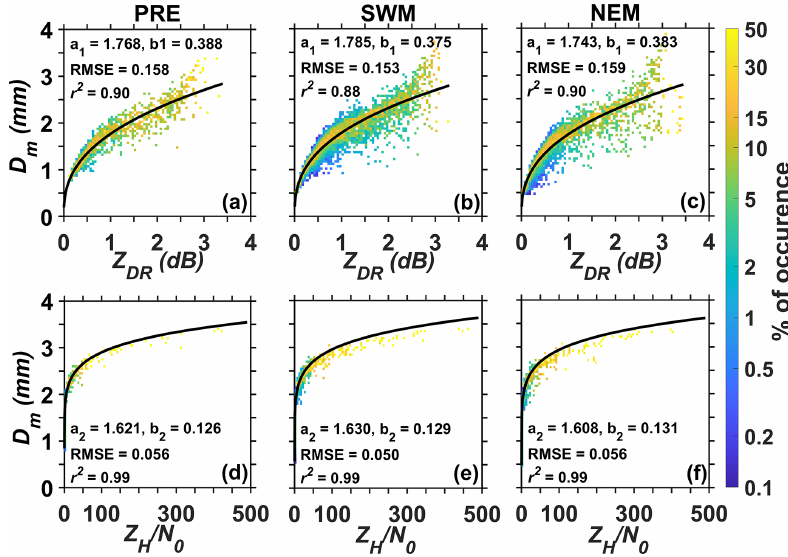
Figure 2. Scatter plots between Z DR and D m for the (a) PRE, (b) SWM and (c) NEM seasons. (d–f) Same as (a) – (c) but for Z H /N 0 and D m . The color indicates the percentage occurrence of data in each cell. The power law regression fit is overlain (solid line) on the